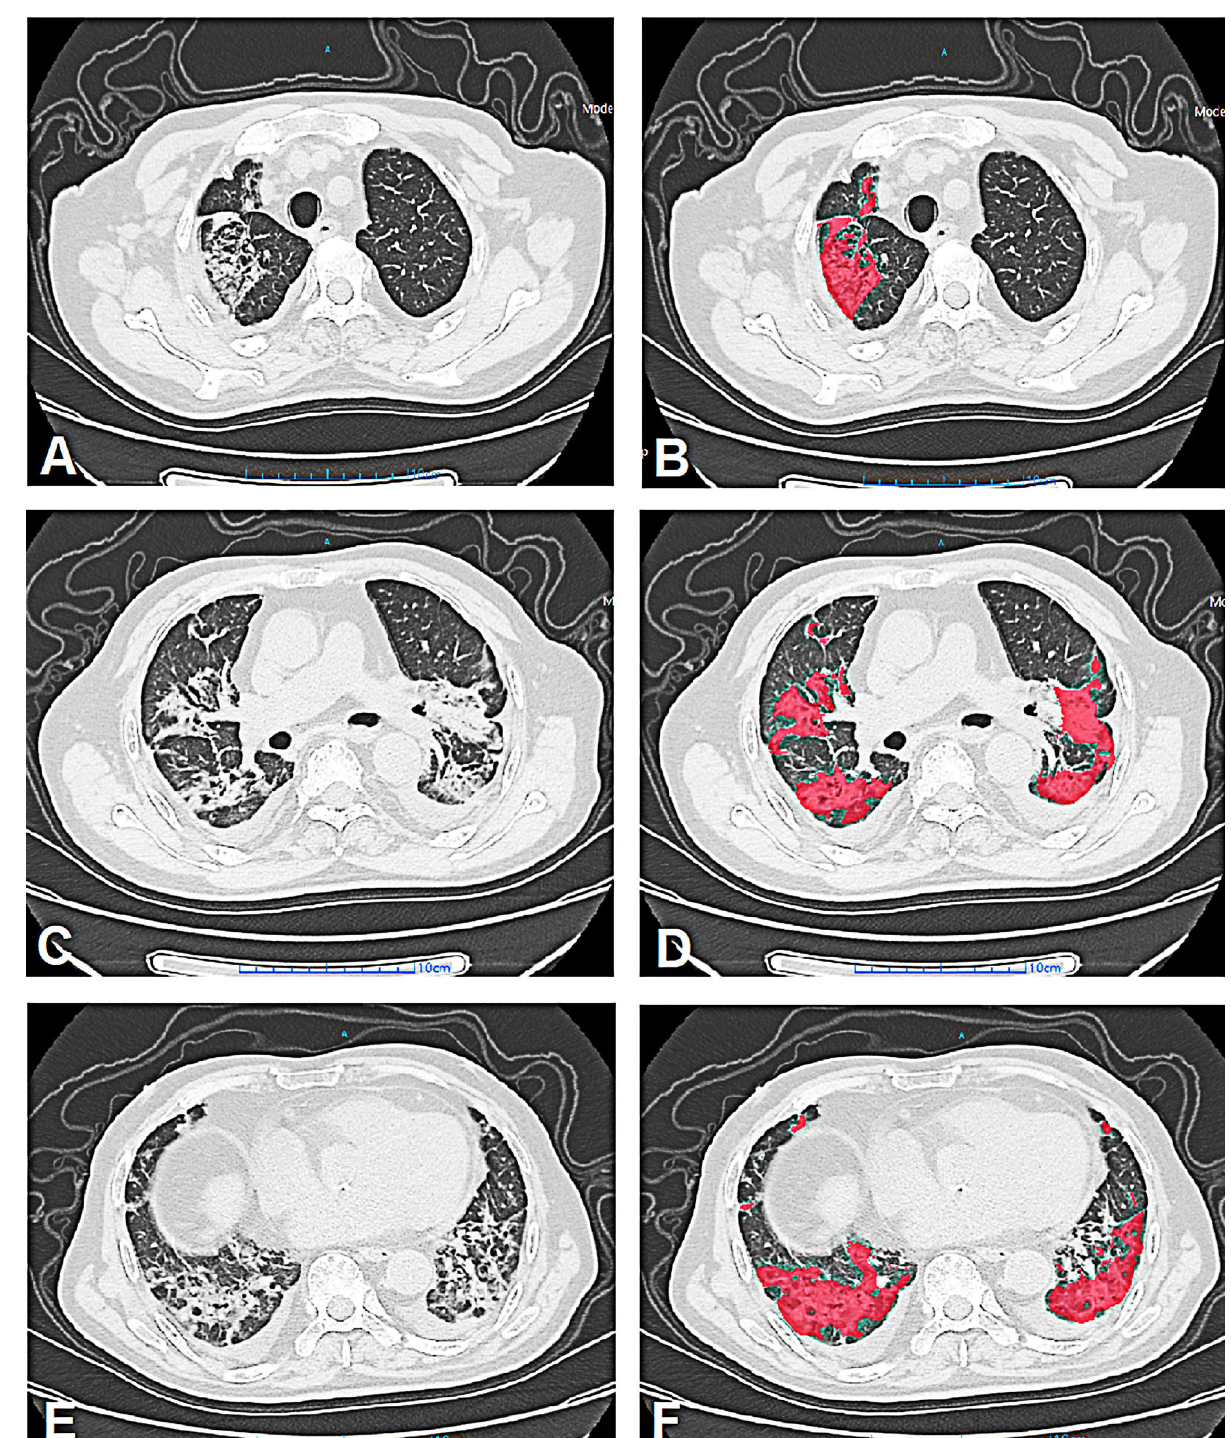
Figure 3. Representative case of a 78-year-old male patient with COVID-19 from progress-to-severe group. Initial chest CT on admission showed multiple GGO lesions from upper ( A , B ), middle ( C , D ) and lower ( E , F ) zones. The CT severity score was 11. The GGO volume, GGO volume percentage, consolidation volume and consolidation volume percentage were measured as 252.56 cm 3 , 15.08%, 90.45 cm 3 and 5.4% respectively. COVID-19 Coronavirus disease 2019, CT computed tomography, GGO ground glass